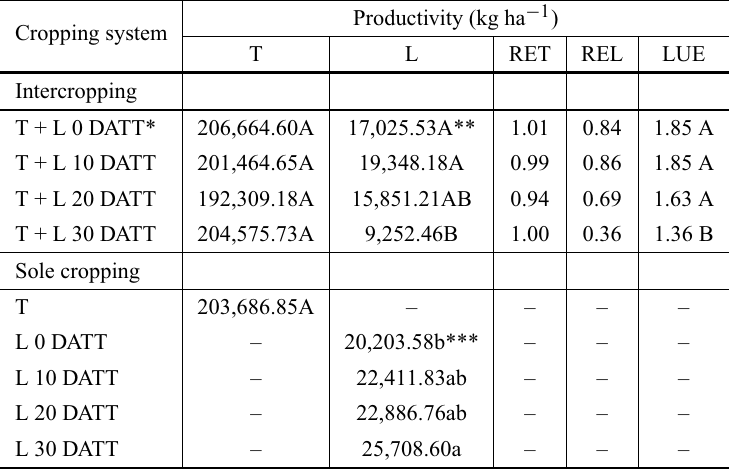
*DATT = days after the transplanting of tomato; **Means, in each column, followed by the same capital letter, are not significantly different at the 5% level of probability, according to the Tukey’s test; ***Means, in each column, followed by the same small case letter, are not significantly different at the 5% level of probability, according to the Tukey’s